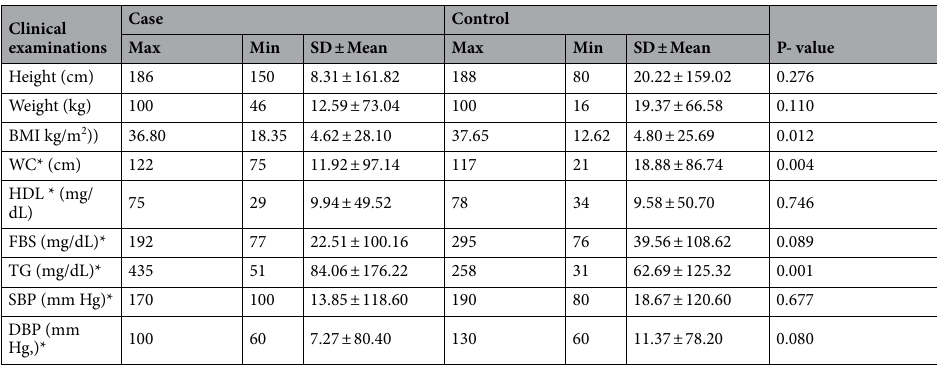
Table 3. Metabolic syndrome components in the case and control groups. *Metabolic syndrome parameters. BMI: body mass index, WC: waist circumference; TG: triglyceride; HDL: a high-density lipoprotein; FBS: fasting blood sugar; SBP: systolic blood pressure; DBP: diastolic blood